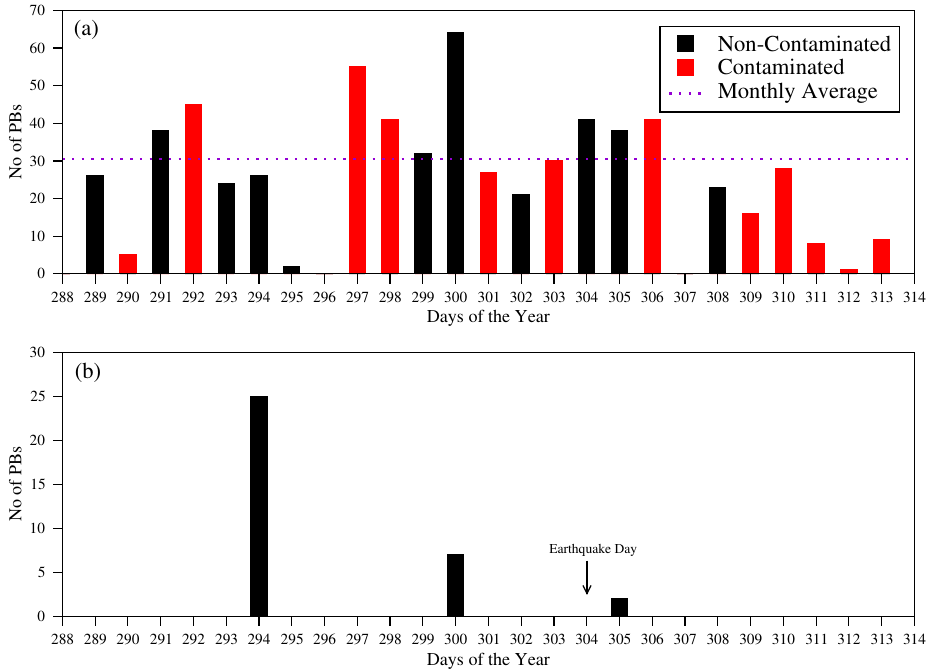
Figure 15. Diurnal variation of particle bursts from 15 October to 9 November 2020. ( a ) The black histograms are for quite solar days, and the red histograms are contaminated due to solar activity. The dashed horizontal line indicates the average PB. ( b ) The lower panel shows the enhancement of PB on ten and four days before the